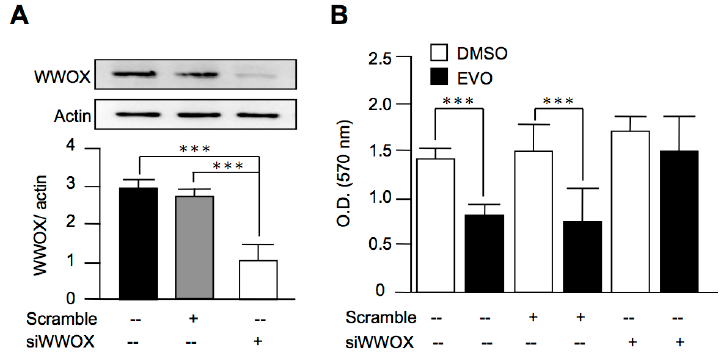
Figure 5. Evodiamine inhibited HepG2 cell proliferation through a WWOX-dependent pathway. ( A )